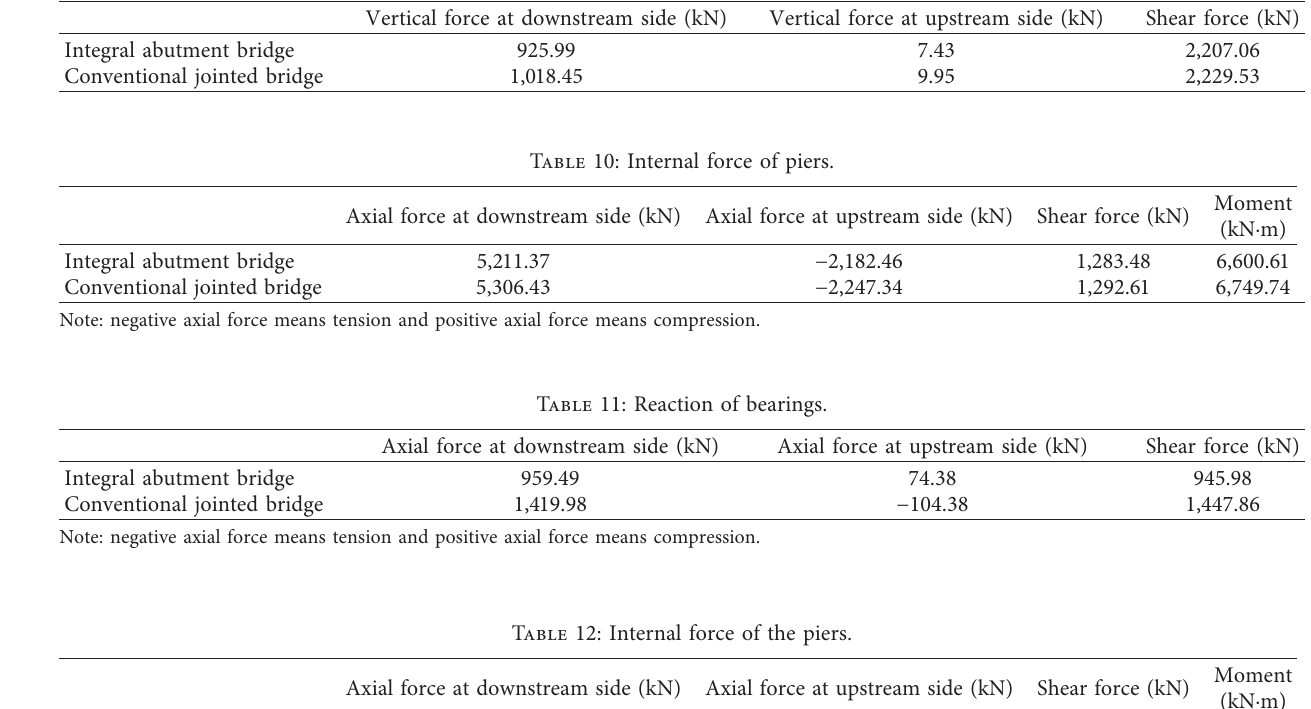
Table 9: Reactions of bearings.